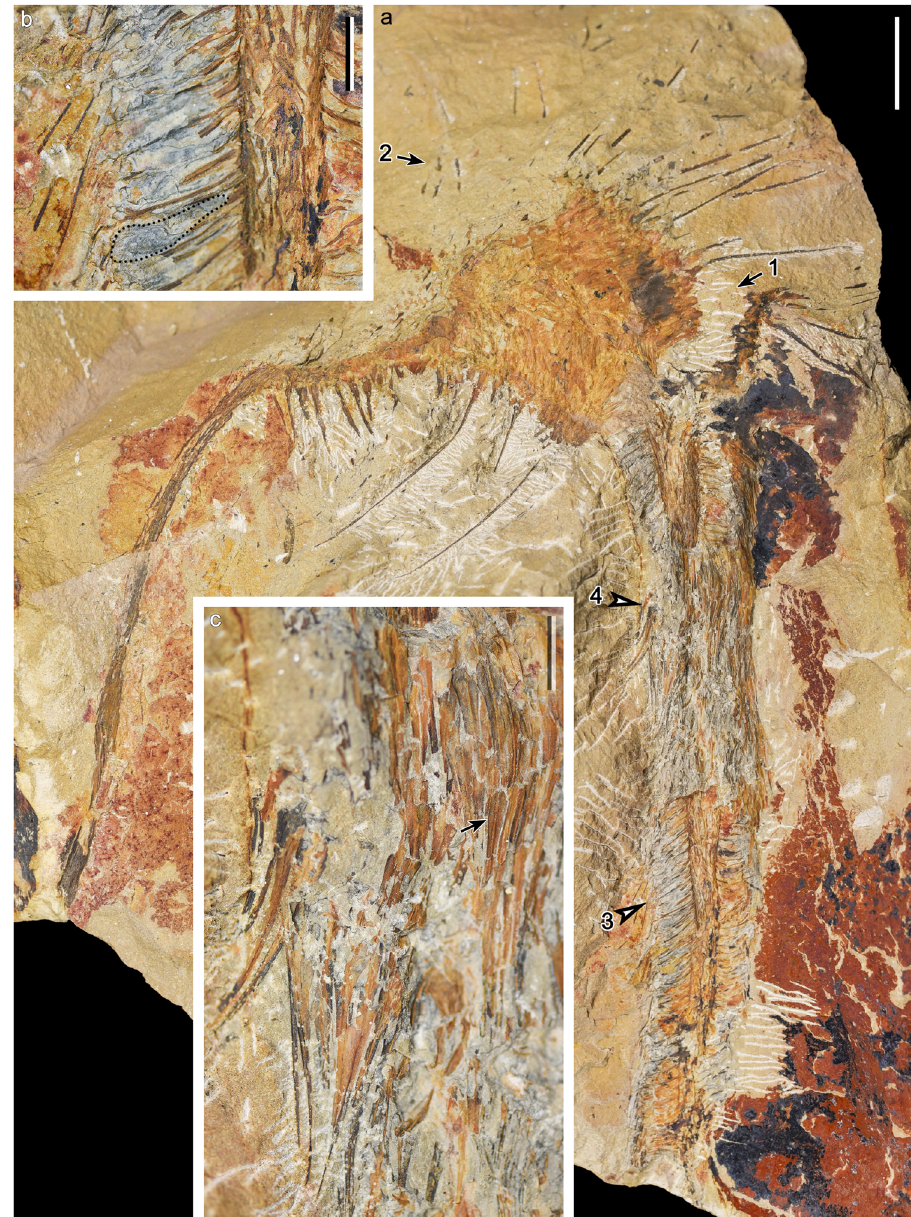
Fig. 2 The type specimen of Omprelostrobus gigas gen. et sp. nov. Scale bars: a, 2 cm. b, c, 5 mm. a Strobilus terminating the fertile axis. Arrow 1 indicating fractures near the boundary between the proximal and distal portions, and arrow 2 indicating sporophylls in rock matrix. Arrows 3 and 4 indicating portions enlarged in b , c , respectively. PKUB19306. b Enlargement of a (arrow 3), displaying the strobilar axis and sporophylls on one side. Dotted line indicating the contour of a sporangium. c Enlargement of a (arrow 4), displaying sporophyll laminae in face view. Arrow indicating laminae with strong